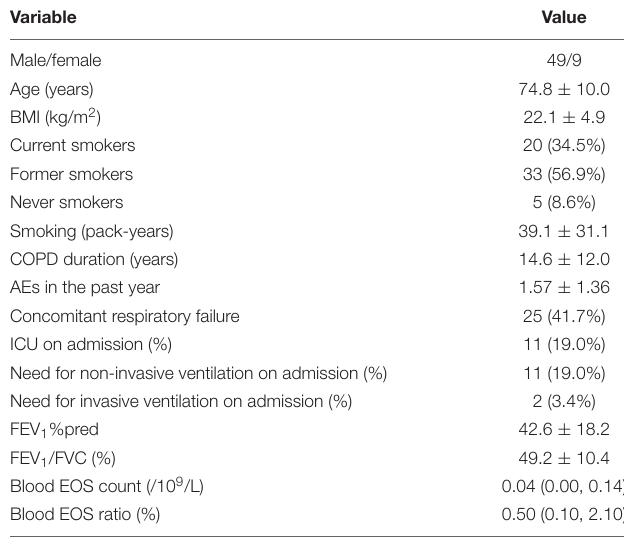
TABLE 1 | General information of patients with